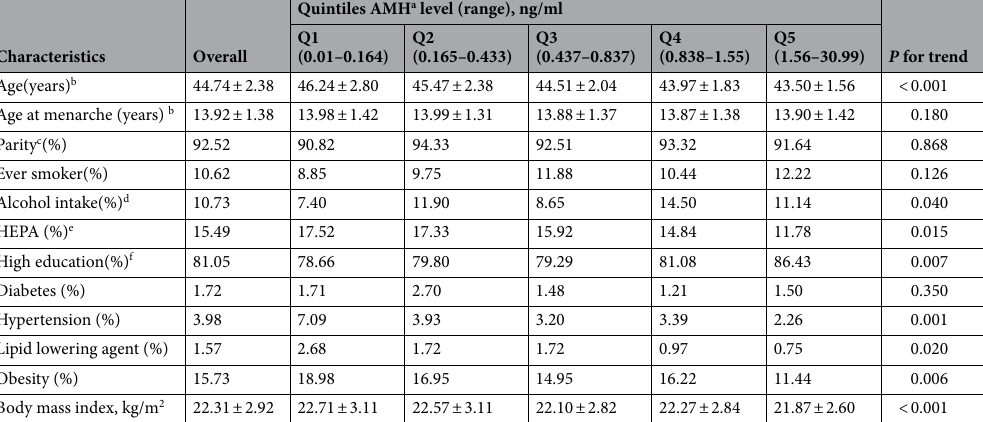
Table 1. Baseline characteristics of premenopausal Korean women free of vasomotor symptoms (n = 2,041). a AMH = Anti-Müllerian Hormone, Data are b mean ± standard deviation, c Parity including live births and stillbirths, d ≥ 10 g of ethanol per day, e HEPA = health-enhancing physical activity, f College graduate or higher.